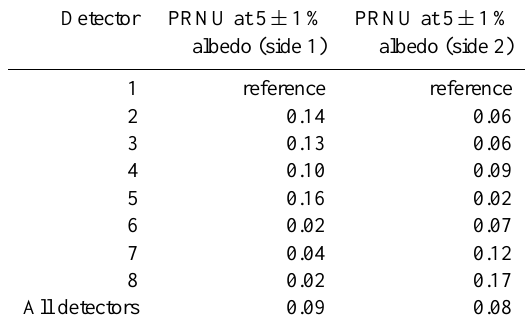
Table 3. PRNU of VIS detectors at 5 ± 1% albedo. PRNU should be less than one-third of noise-equivalent delta radiance derived